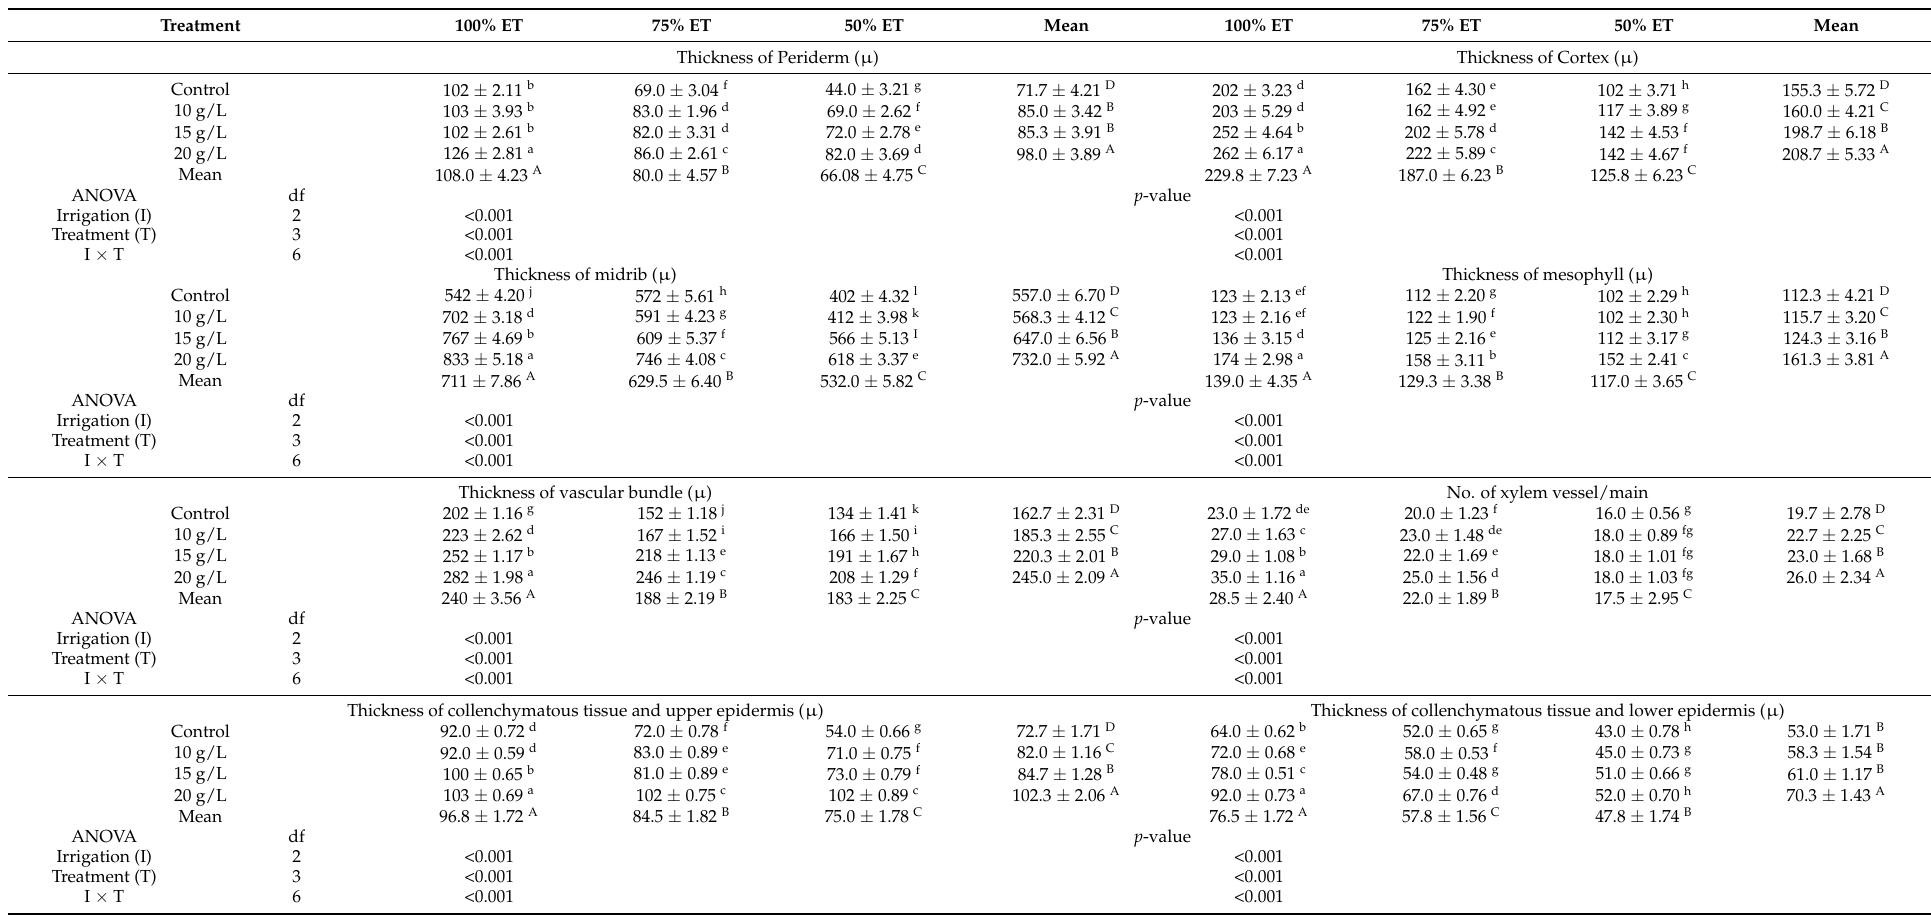
Table 3. Influence of potassium silicate at different concentrations on anatomical characters of squash plants under different irrigation regimes.